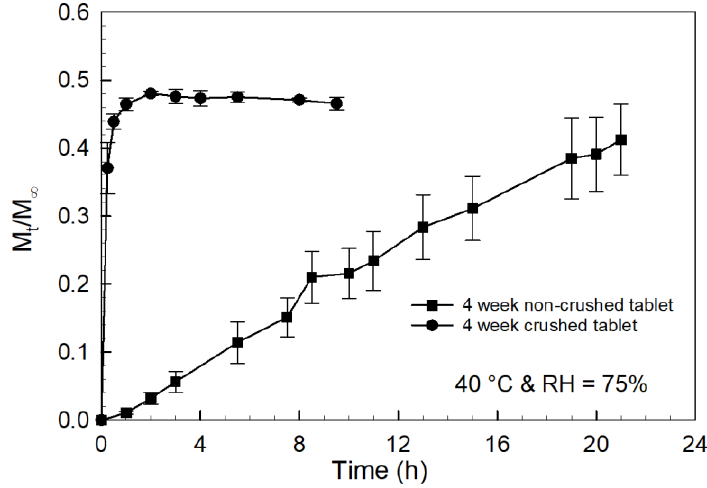
Figure 8. Curcumin release profiles for PCBAE prodrug tablets stored at accelerated conditions for 4 weeks with analysis using UV–Vis method. Crushed tablet compared with a non-crushed tablet.